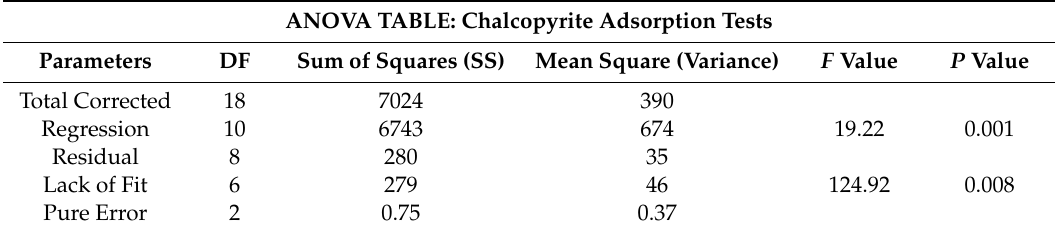
Table 7. ANOVA Summary for collector adsorption on pentlandite. ANOVA TABLE: Chalcopyrite Adsorption